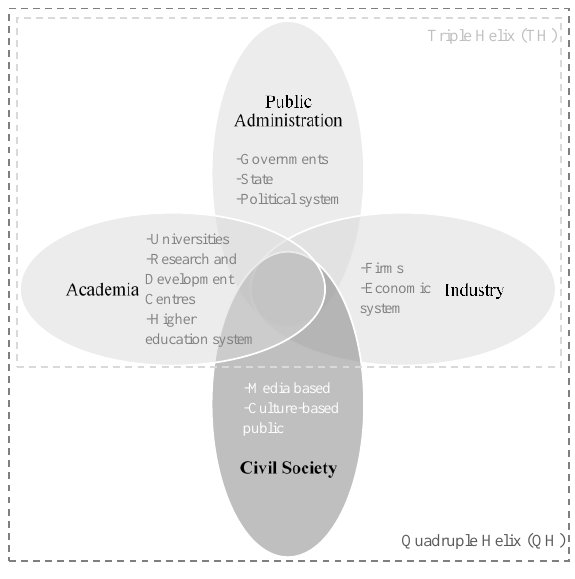
Figure 1. Triple and Quadruple Helix